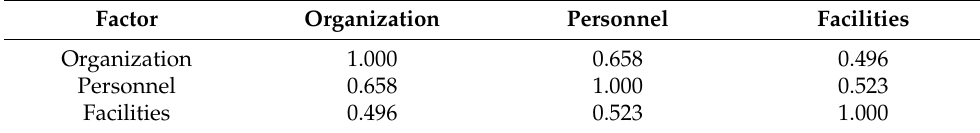
Table 4. Correlations between the